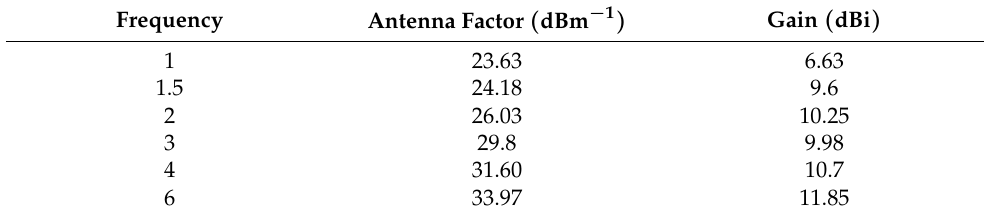
Table 5. Gain and antenna